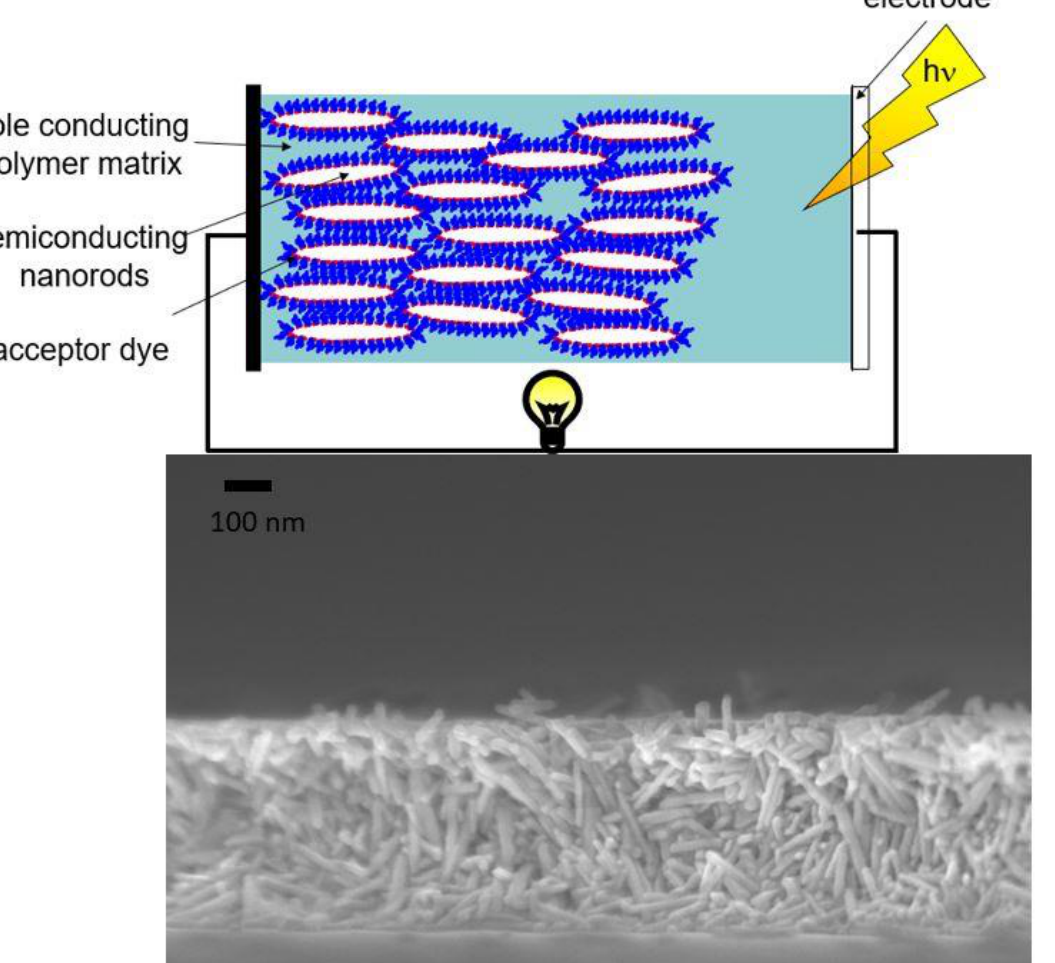
Figure 7. Schematic representation of a photo-voltaic cell optimized for an effective transport of the negative charge to the electrode and an assembly of ZnO nano-rods on an electrode; lower part reproduced with permission of [114], published by Wiley-VCH, 2010.